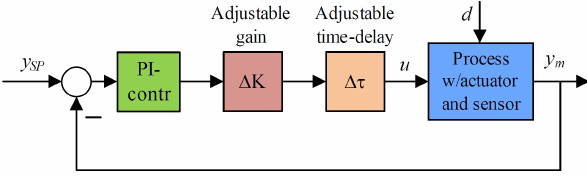
Figure 3: An adjustable gain and time-delay are in- serted into the loop to find the stability mar- gins (gain margin and phase margin) experi-